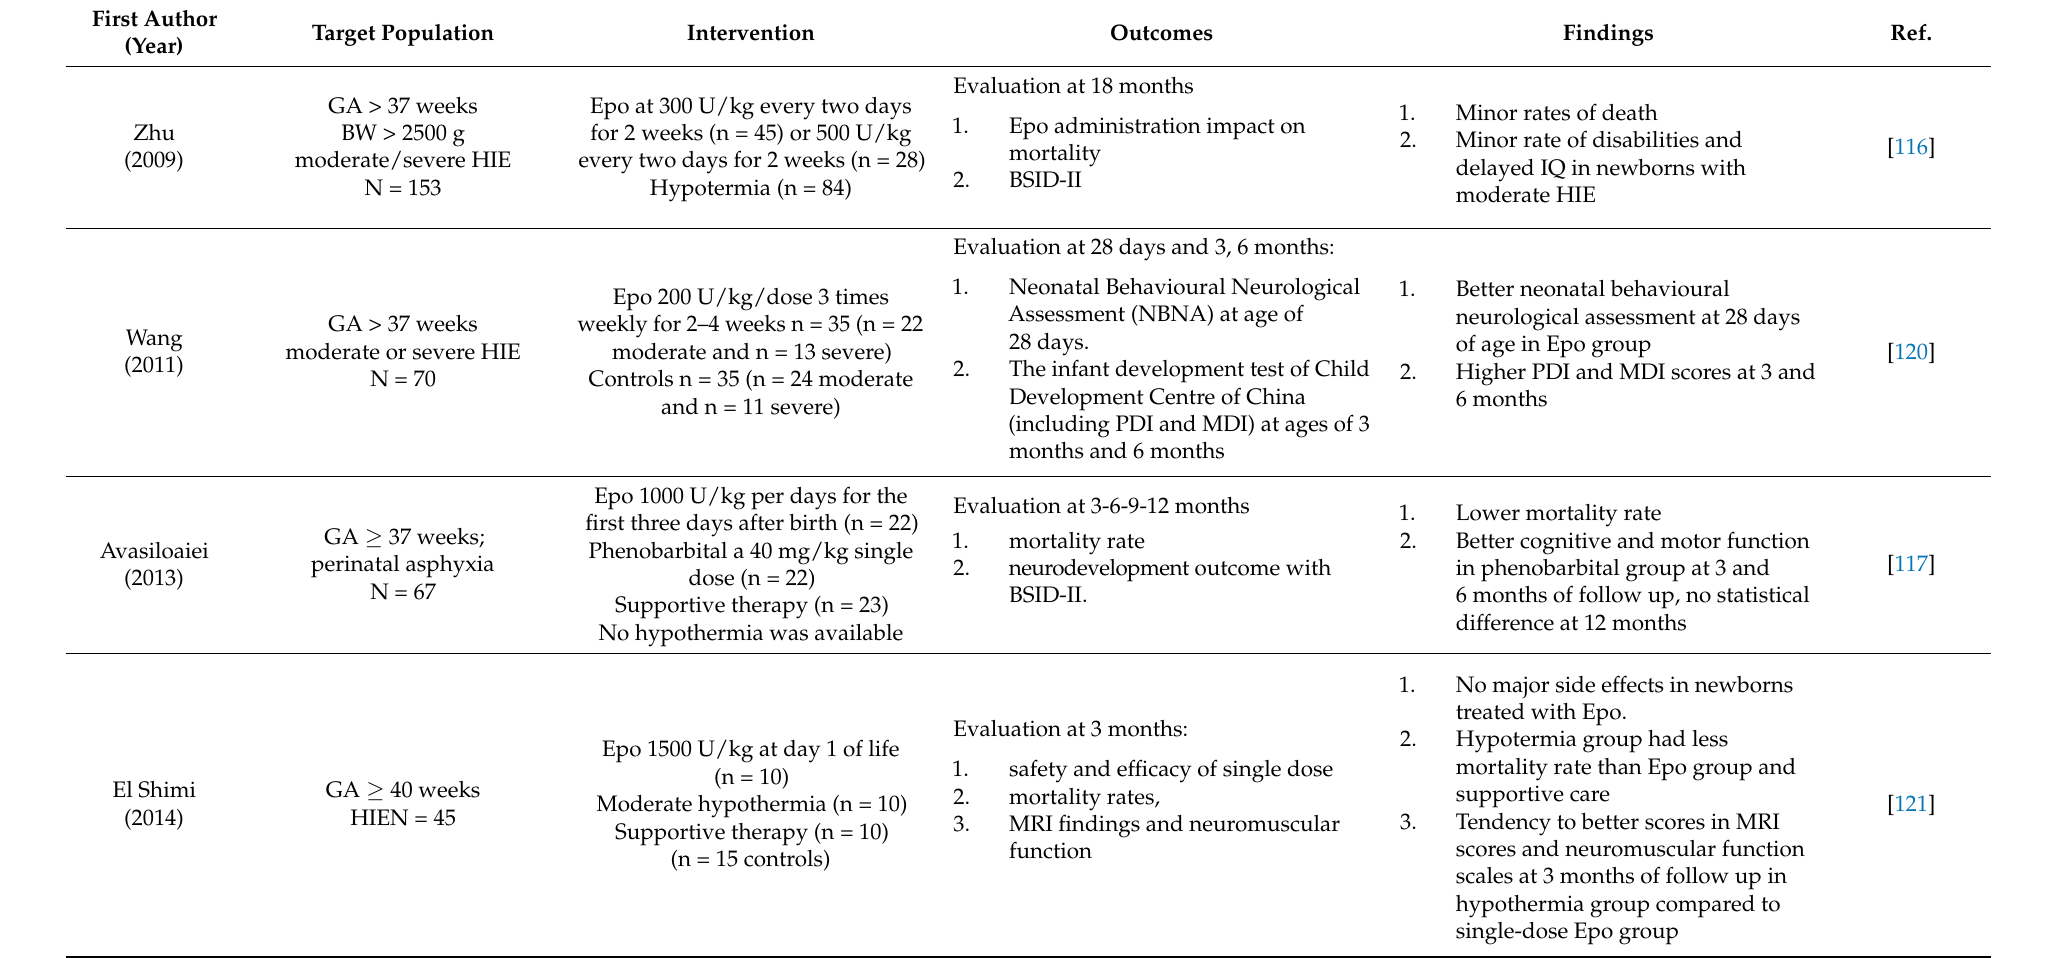
Table 2. Erythropoieti (Epo) administration in